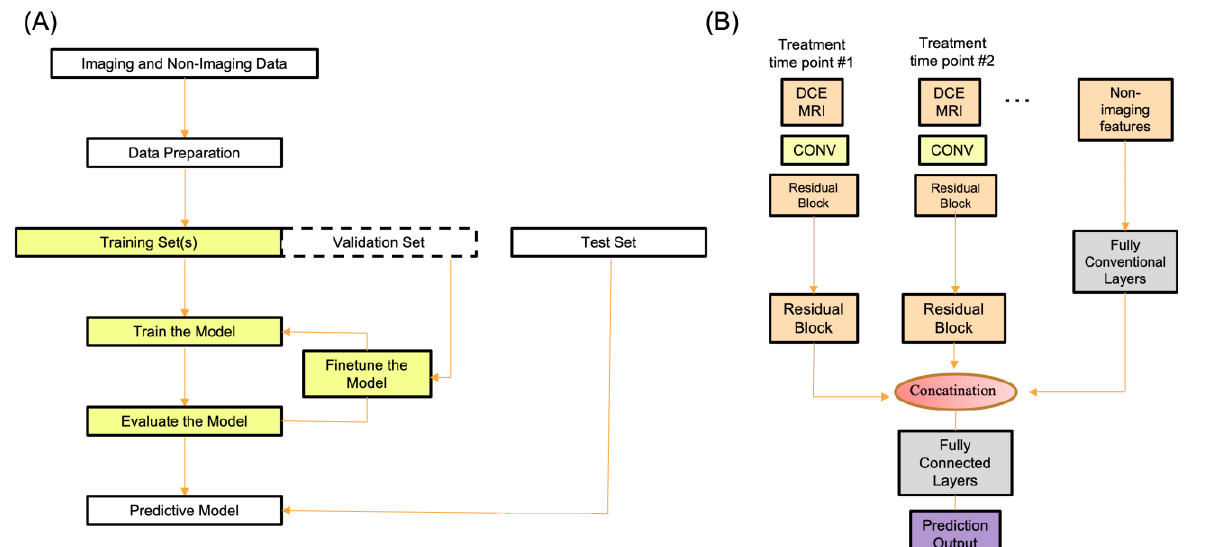
Figure 2. ( A ) A typical flowchart of inputs, data curation, training, and evaluation of DL methods. ( B ) A CNN model of how DCE data at multiple treatment time point and non-imaging data are incorporated. Abbreviations: DCE: dynamic contrast enhanced MRI; Conv: convolutional neural network.